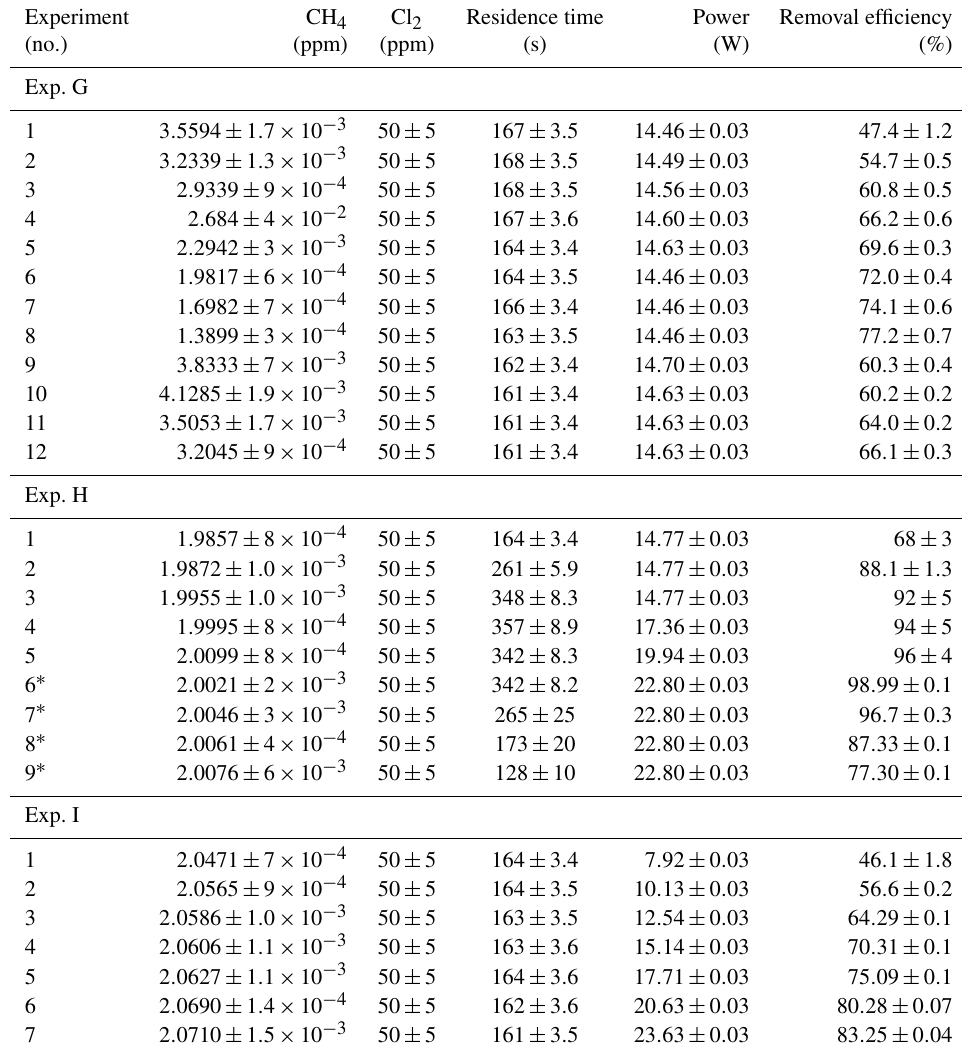
Table D3. Data from exp. G–I. Columns: experimental steps, [CH 4 ] (ppm), [Cl 2 ] (ppm), residence time in seconds, power in watts and the resulting removal efficiency (%).